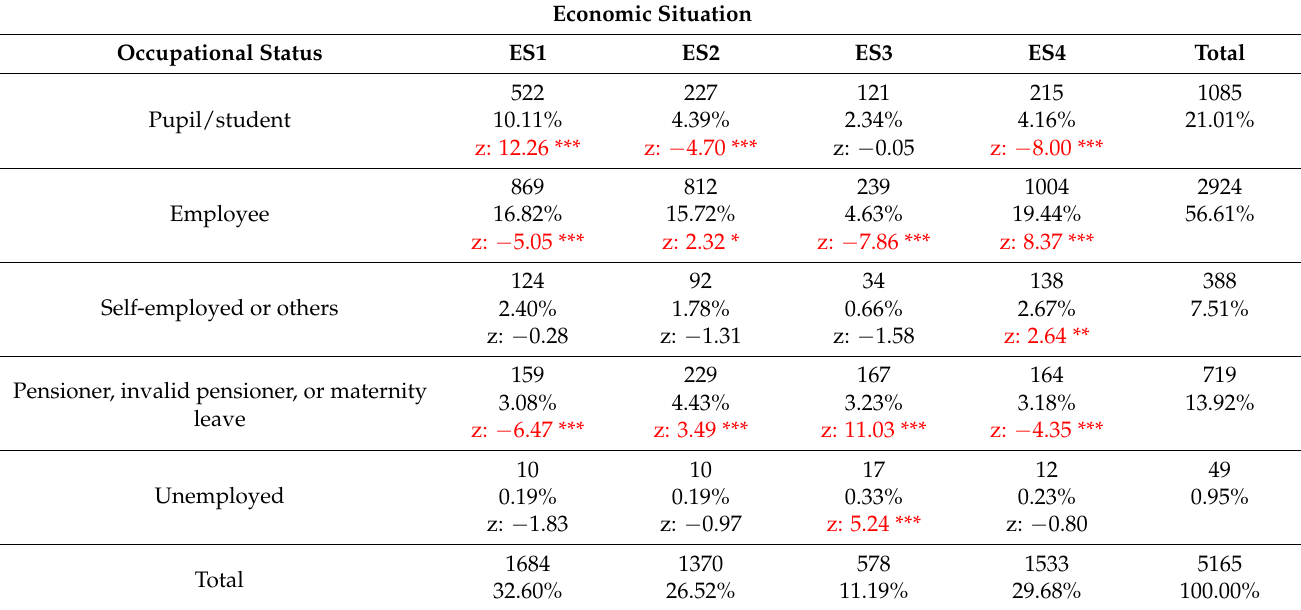
Table 4. Economic situation’s dependence on occupational